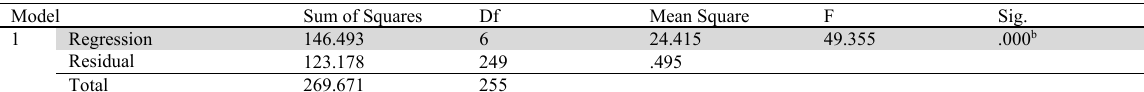
The results of ANOVA a test Model